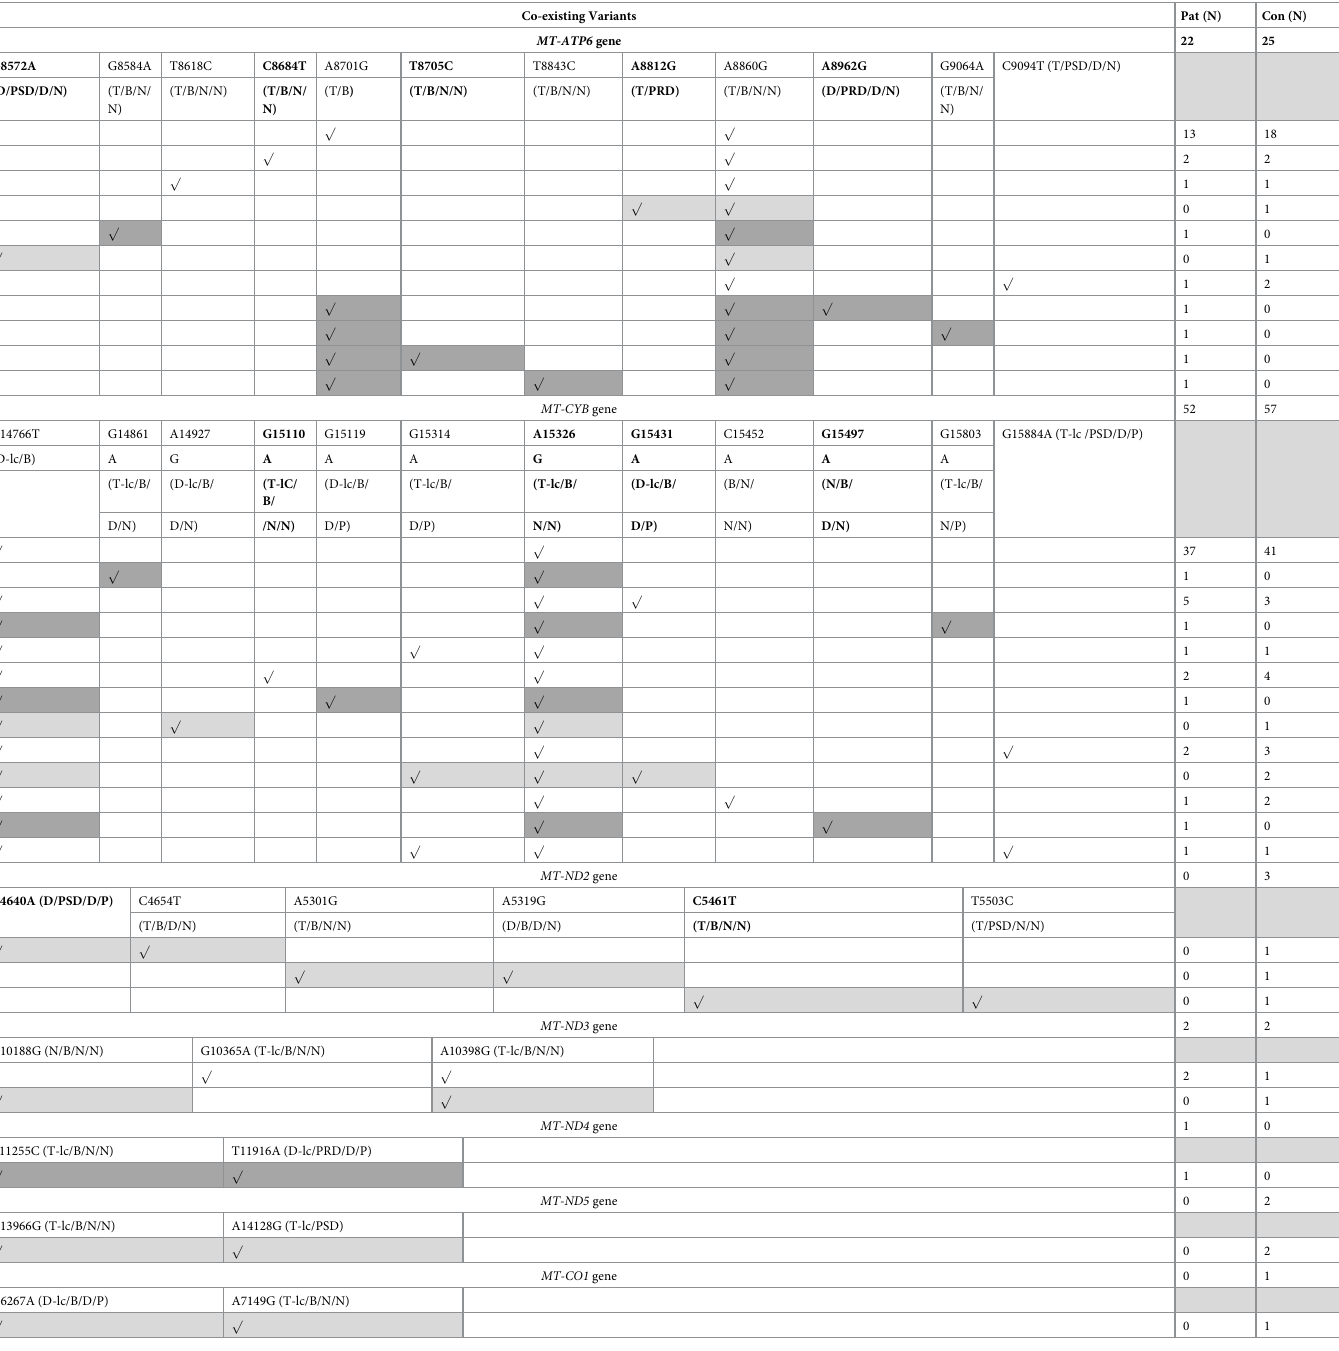
Table 2. Unique combinations of co-existing missense variants and pathogenicity prediction by SIFT and Polyphen2 and reported in CADD and APOGEE. Vari- ants for which SNAP 2 score was > 50 or con-surf value was 8 or more are shown in bold.